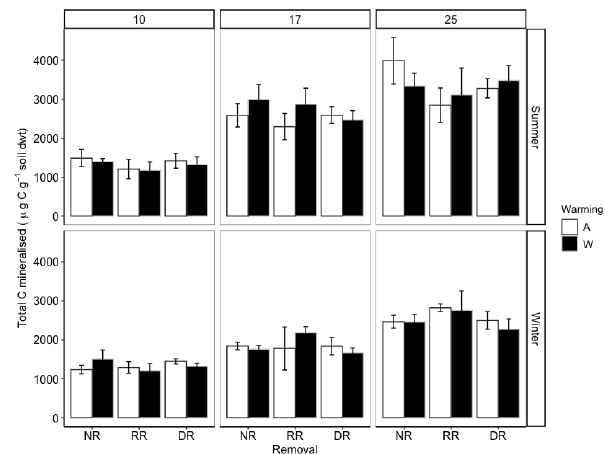
Figure 5. Total C mineralised in summer and winter from soils in no removal (NR), random removal (RR), and dominant removal (DR) plots at incubation temperatures of 10, 17, and 25 ◦ C for warmed (W) and ambient (A)